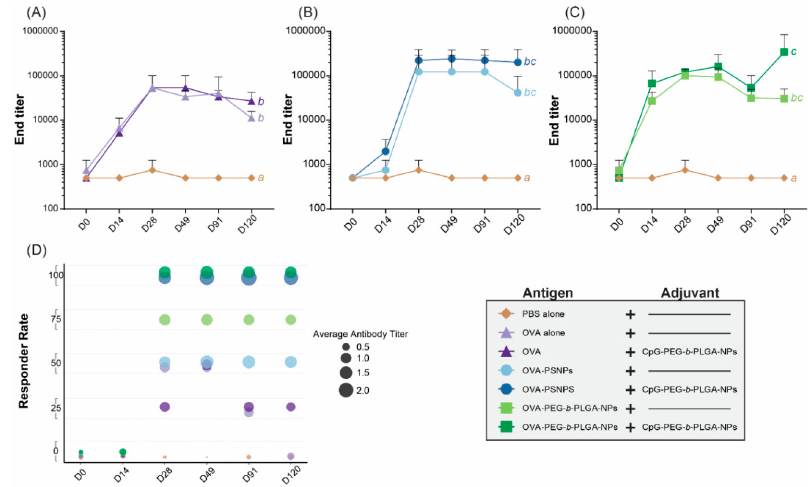
Figure 2. Antibody end titers over time. C57BL/6 mice were immunized twice, two weeks apart, intradermally at the base of the tail with the following formulations; PBS alone (Naïve), OVA alone, OVA + CpG-PEG- b -PLGA nanoparticles (NPs), OVA-PS NPs, OVA-PS NPs + CpG-PEG- b -PLGA NPs, OVA-PEG- b -PLGA NPs, or OVA-PEG- b -PLGA NPs + CpG-PEG- b -PLGA NPs. Treatments without a common letter were found to be statistically significant ( α = 0.05) via a Kruskal–Wallis test with Mann–Whitney pairwise post-hoc comparisons. Comparison of ( A ) OVA alone with and without CpG-PEG- b -PLGA NPs, ( B ) OVA-PS NPs with and without CpG-PEG- b -PLGA NPs, and ( C ) OVA-PEG- b -PLGA NPs with or without CpG-PEG- b -PLGA NPs. All animals received 50 µg OVA. For CpG-PEG- b -PLGA NP groups, mice received 5 µg CpG. Graphs show average end titers for each group at each day ( D ) timepoint, D0, D14, D28, D49, D91, and D120. End titer was calculated as the closest to average of naïve mice + 3 SD, results shown as average ± SD for each time point (n = 4 mice per group). ( D ) Responder rate (%, n = 4 mice per group) and average antibody titer for each immunogen treatment as defined as OD420 above 1.0 at dilution 1500 (from Figure